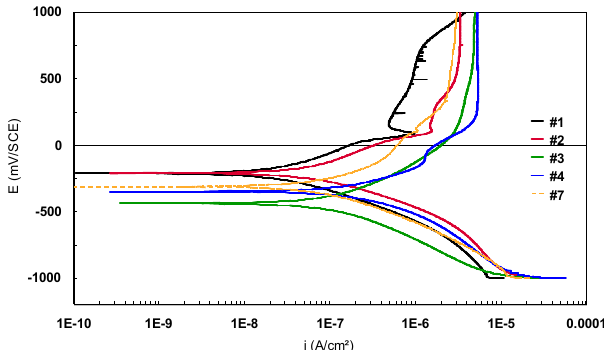
Figure 14. Potentiodynamic polarization curves recorded in 9 g / L NaCl electrolyte for theTi-based alloys (semi-logarithmic scale).